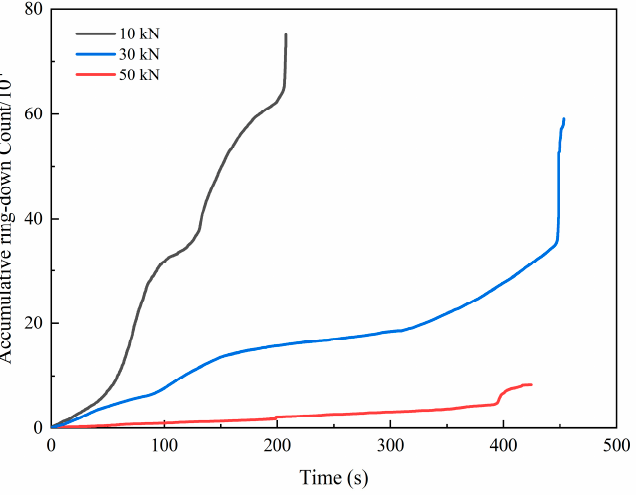
Figure 9. The curve of AE cumulative ring-down count with time under different dynamic normal loads.